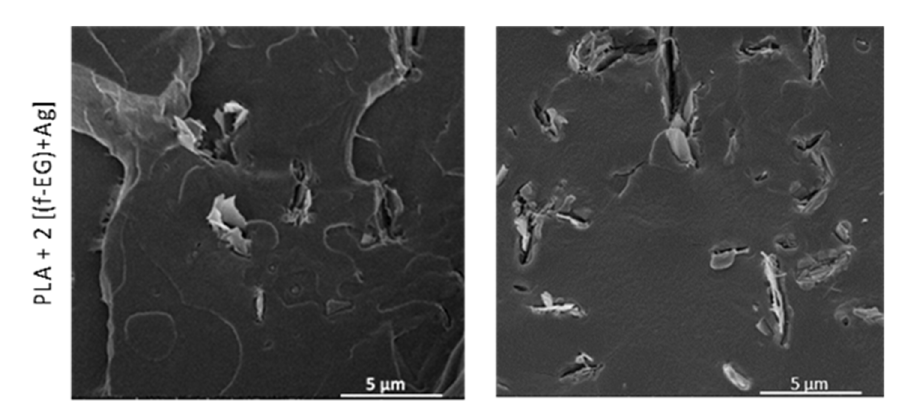
Figure 10. SEM images of Fil3D and FilText: PLA; PLA+2 EG; PLA+2 f-EG; PLA+2 [(f-EG)+Ag].